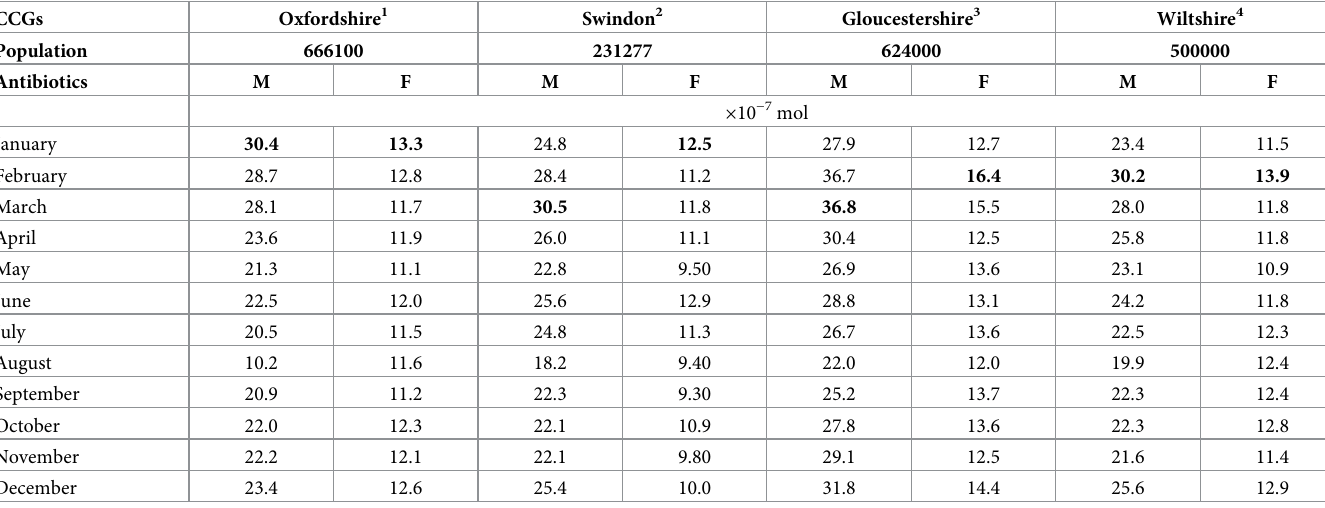
Population statistics are provided by the respective Annual Report for the CCG. Bolded values in each column represent the month with the maximum prescription rate in 2015. These were selected for use in the model to ensure a realistic worst-case scenario.